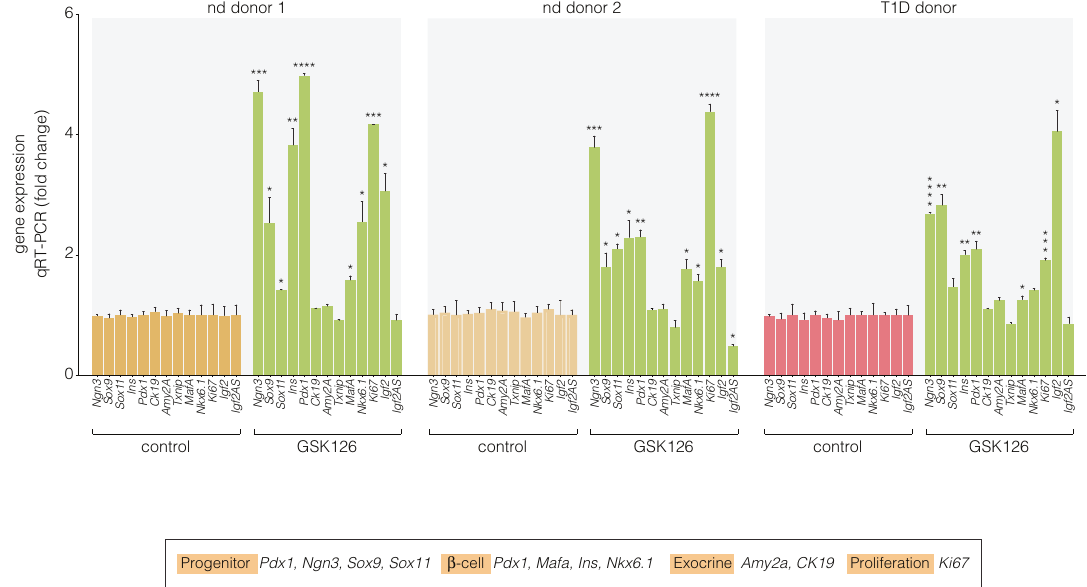
Fig. 4 GSK-126 restores the expression of islet indices in non-diabetic and type 1 diabetic pancreatic exocrine cells. Correlation of mRNA abundance of Ngn3, Sox9, Sox11, Ins, Pdx1, Ck19, Amy2A, Txnip, Mafa, Nkx6.1, Igf2 and Igf2AS displayed as fold change by qRT-PCR. Signi fi cant changes in mRNA abundance were not detected for the ductal marker (Ck19), acinar marker ( Amy2A ) and the glucose-sensor ( Txnip ). Student ’ s t -test was performed on Control vs GSK-126 (* P < 0.05, ** P < 0.01, *** P < 0.001, **** P < 0.0001 error bars are SEM, n = 3) Signal Transduction and Targeted Therapy (2022)